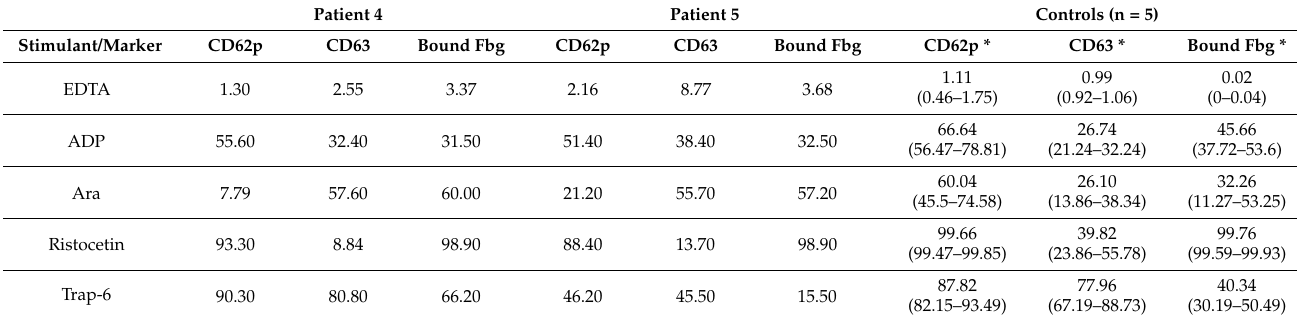
Table 3. Results of flow cytometry with an extended panel of inductors.